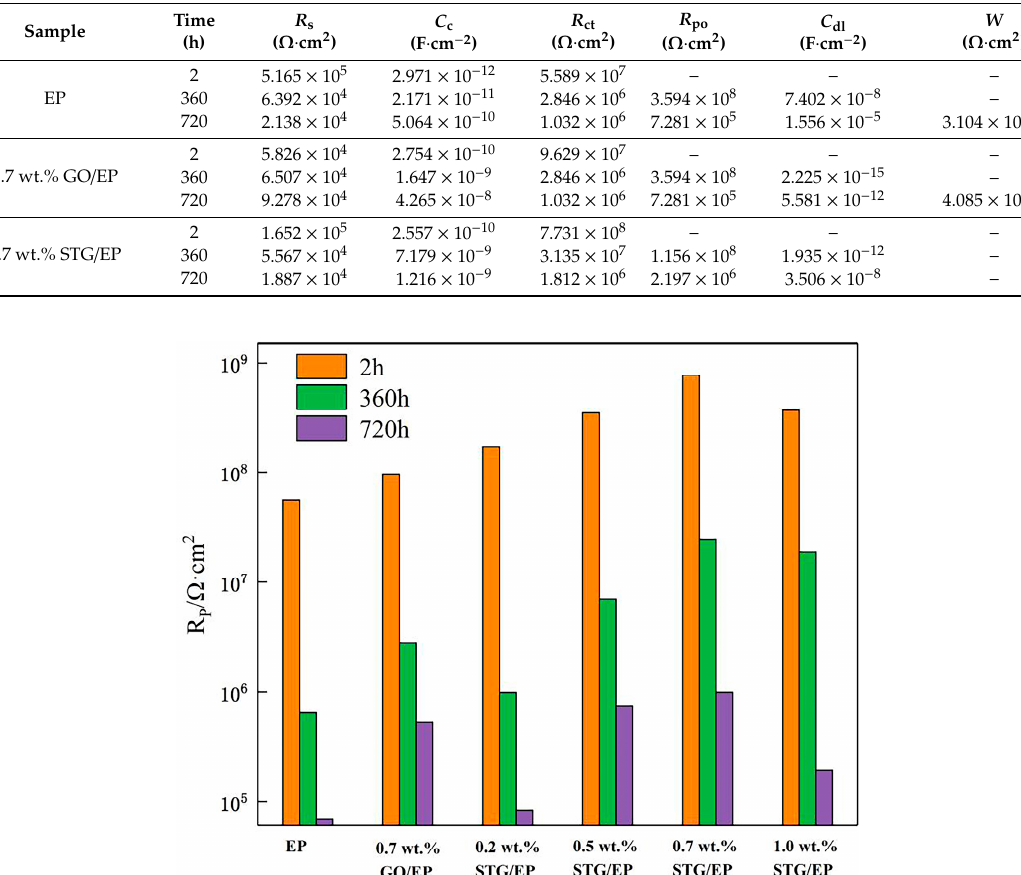
Figure 8. Polarization resistance of the three coatings at immersion times of 2, 360, 720 h in 3.5 wt.% NaCl solution.